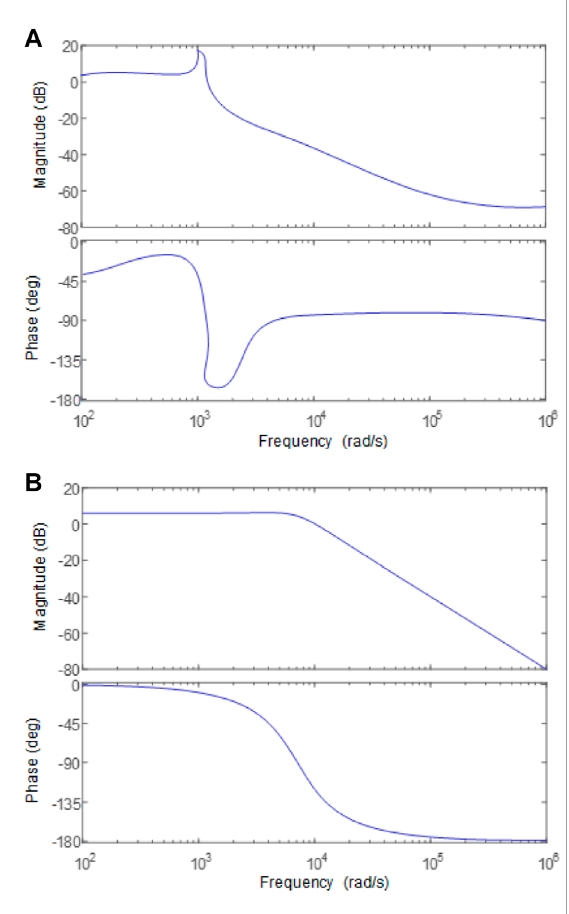
FIGURE 10 (A) Bode diagram without a controller. (B) Bode diagram with a